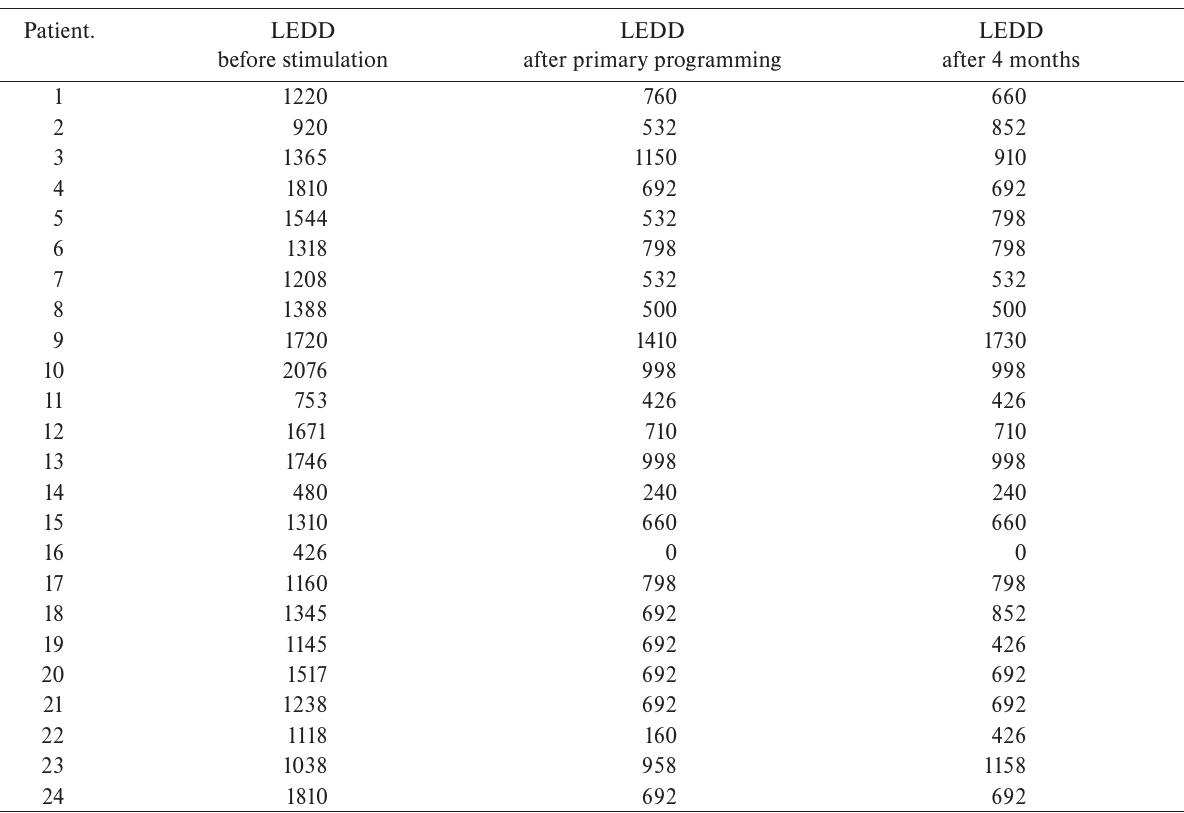
Table 2. LEDD (mg) before the onset of stimulation, after primary programming and after four months for all patients.